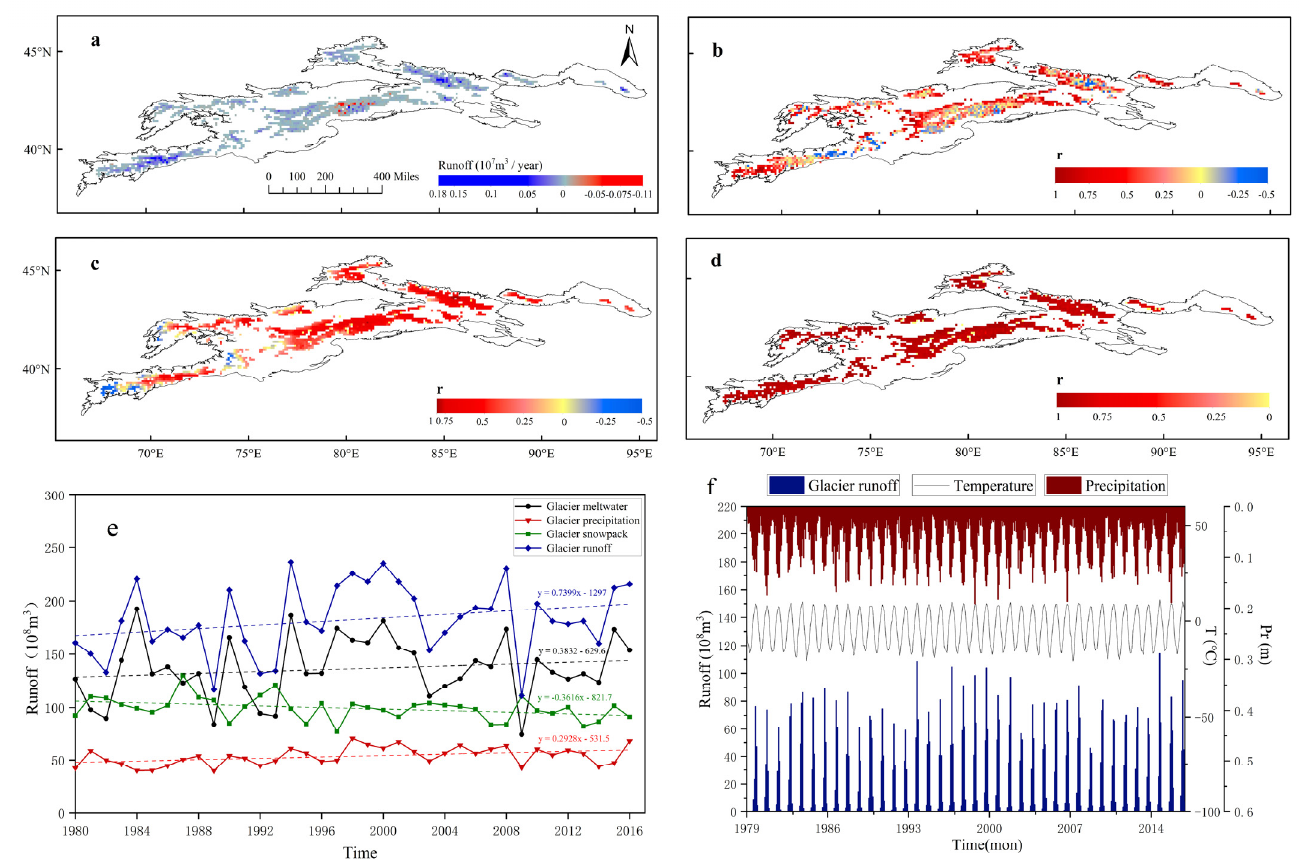
Figure 6. Change in glacier runoff and impact factors in the Tien Shan Mountains from 1980 to 2016. Spatial distribution ( a ) and temporal variations ( e ) of glacier runoff; spatial correlations between glacier runoff and glacier area ( b ), temperature ( c ), and precipitation ( d ) from 1980 to 2016; The monthly temporal variation trend of glacier runoff and influencing factors ( f ).